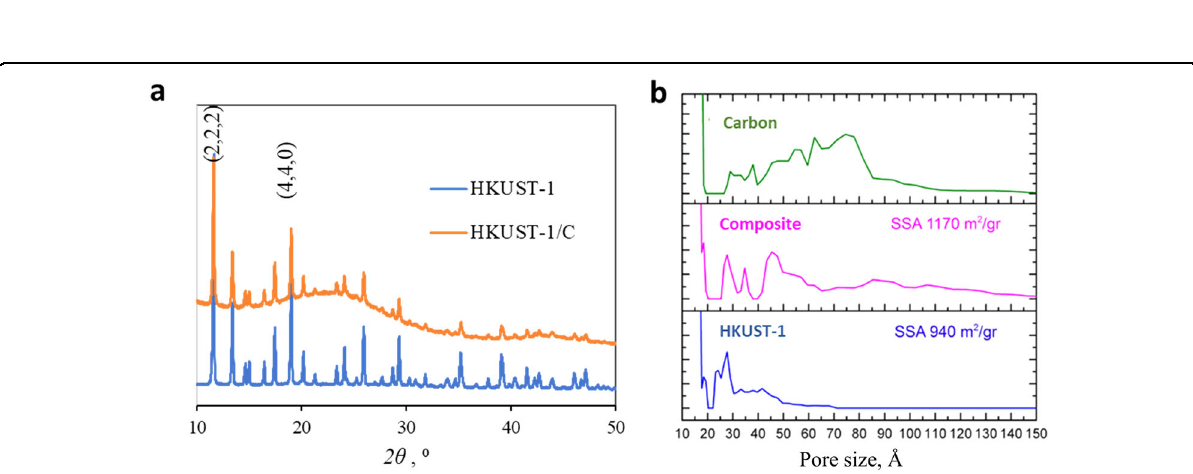
Fig. 2 Physical and chemical characterization of the MOF/carbon composite. a XRD pattern for the MOF and the MOF/carbon composite. b Speci fi c surface area and pore-size distributions of the carbon host (green), the MOFs (blue), and the composite (pink), which were obtained from gas adsorption (N 2 ) measurements and the BET model.